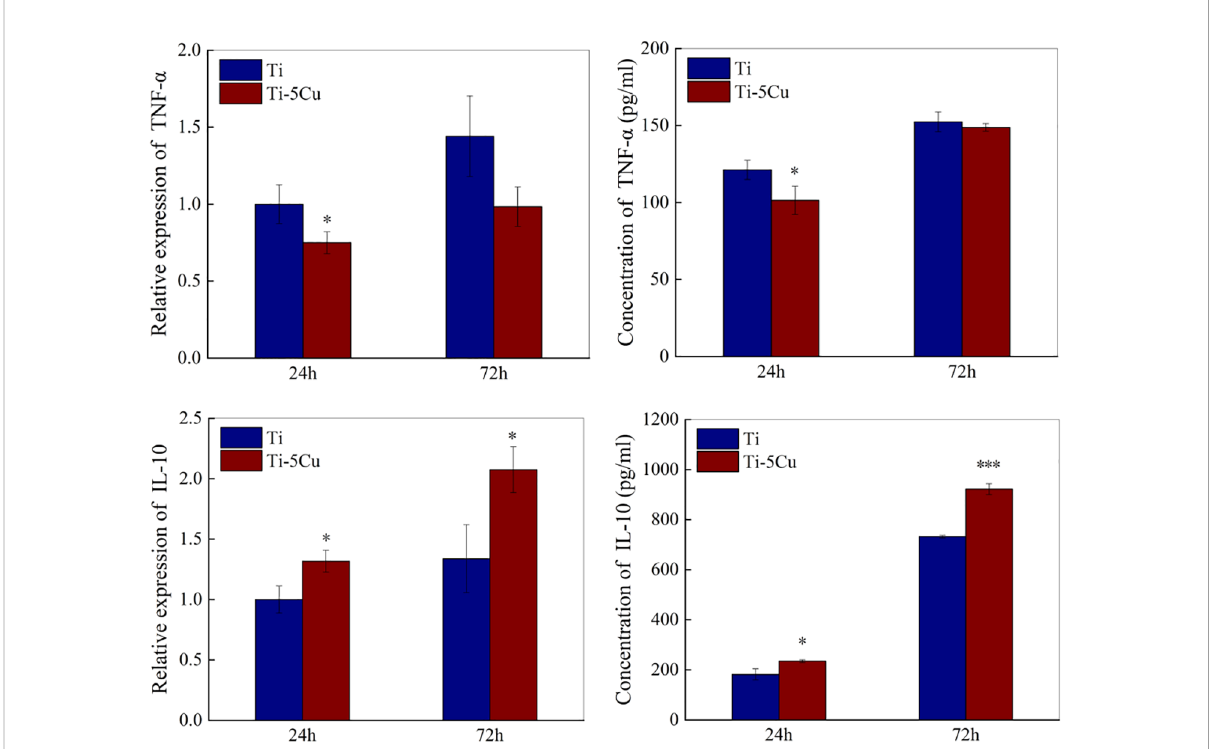
FIGURE 5 The gene and protein expressions of in fl ammatory cytokines of RAW264.7 cells after co-cultured with Ti and Ti-5Cu alloy at 24 and 72 h by RT- qPCR and ELISA (n = 3; *p < 0.05 and ***p <